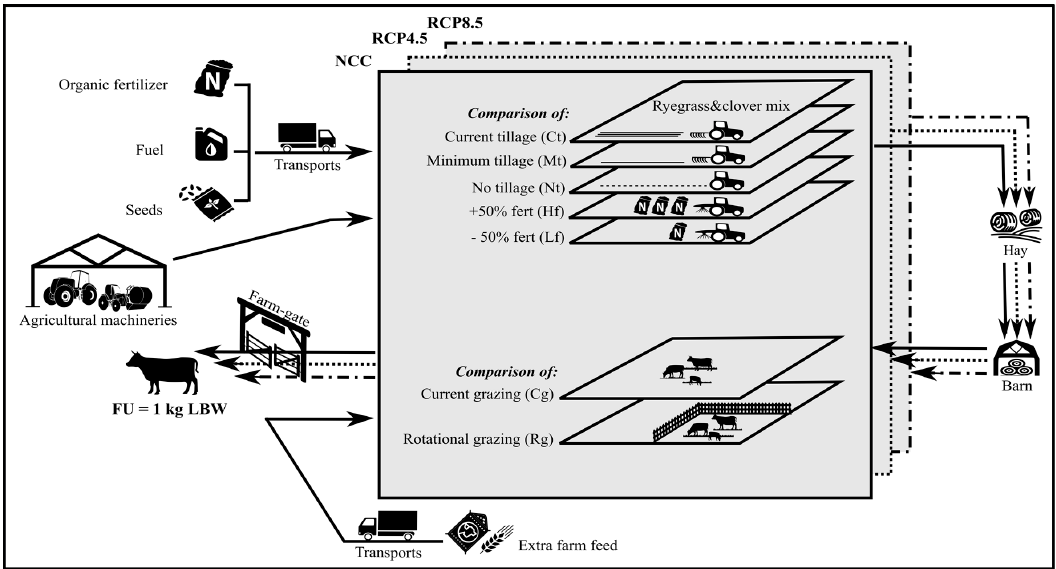
Figure 1. The system boundaries, goods, farm management practices, and climatic scenarios considered. NCC = current climate. RCP = representative concentration pathway. FU = functional unit. LBW = live body weight.